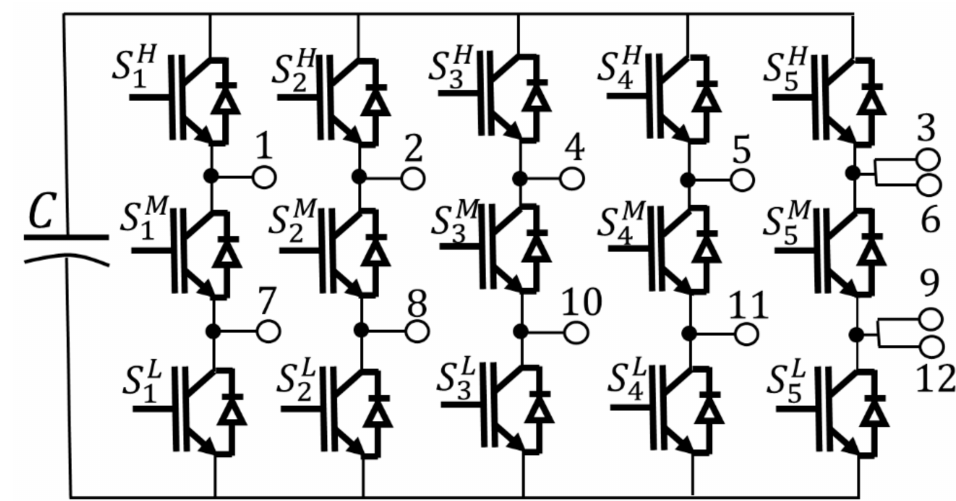
Figure 2. Detailed power circuit for the employed AC/AC converter in Figure